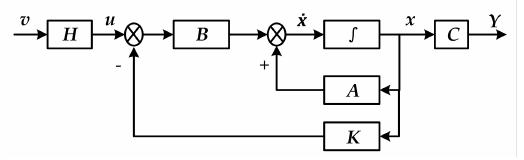
Figure 8. Block diagram of state feedback decoupling